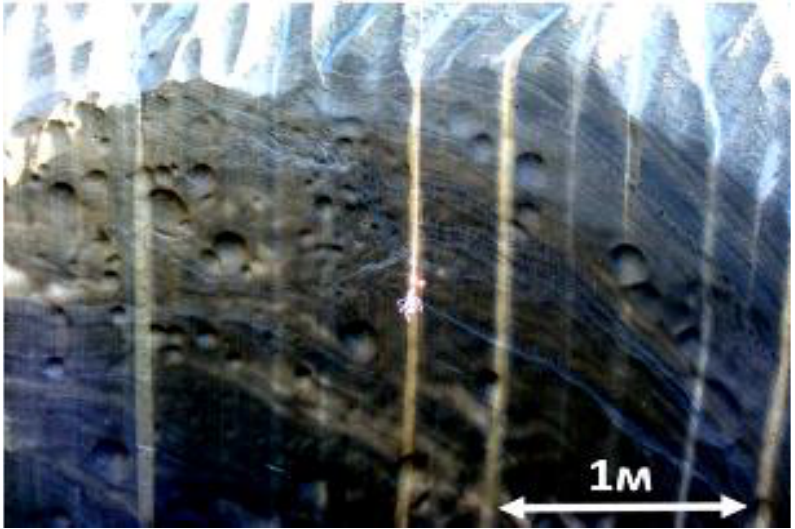
Figure 5. Plastic and discontinuous deformations of the walls of the Yamal crater. Photo credit: V.V. Olenchenko.